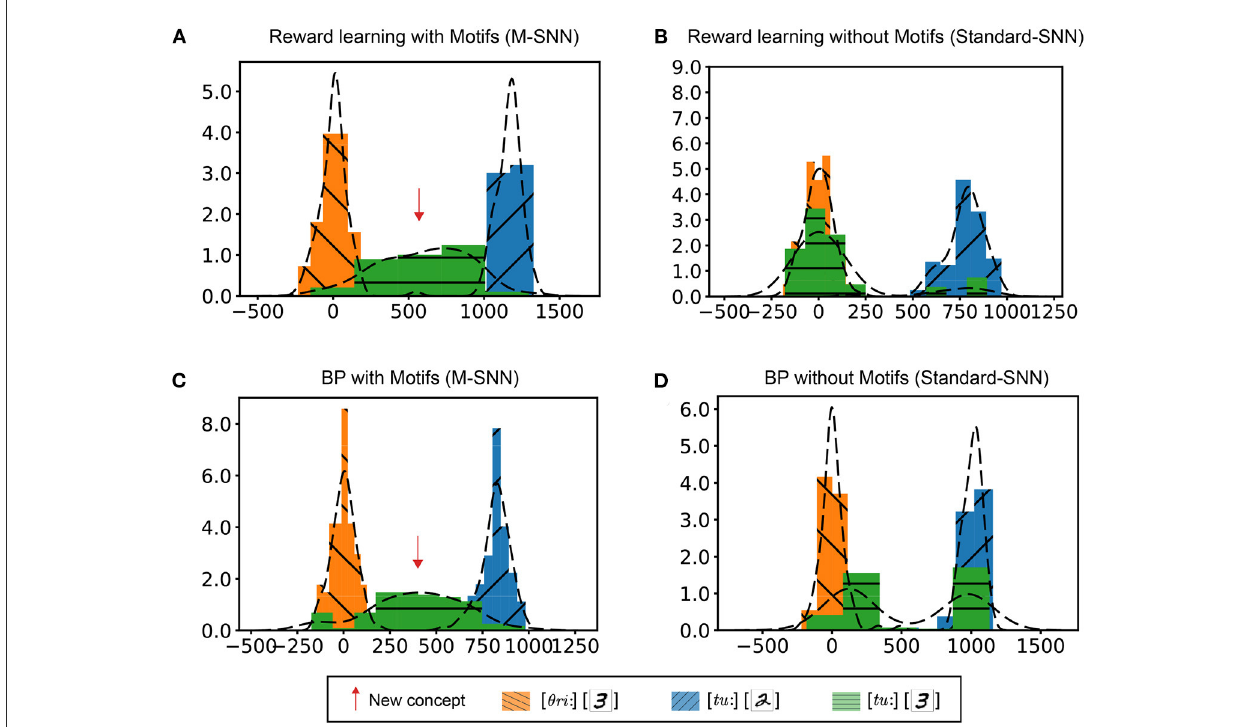
FIGURE5 Simulation of McGurk effect. (A, B) Distribution in the integrated layer after reward learning with Motifs (A) and without Motifs (B) of different combinations of input. (C, D) Distribution in integrated layer after BP learning with Motifs (C) and without Motifs (D) of different combinations of